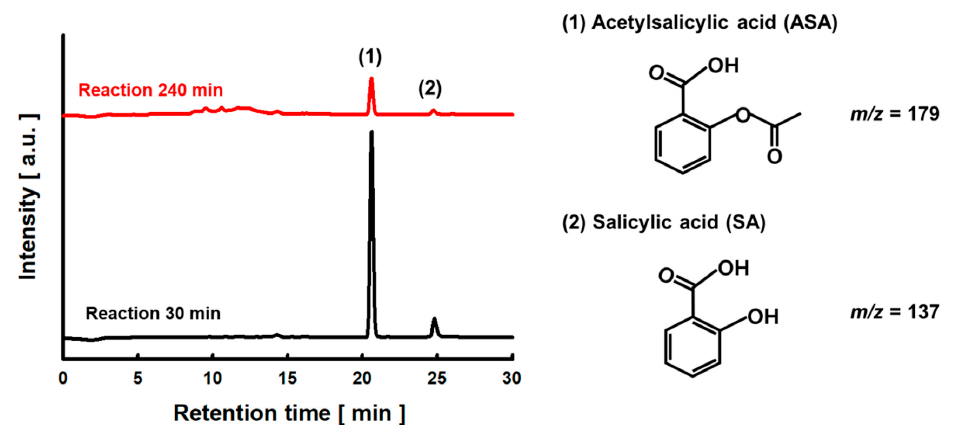
Figure 5. Liquid chromatography–mass spectrometry (LC-MS) chromatogram according to the reaction time of PiLP and name and chemical structure of measured compound by LC-MS.